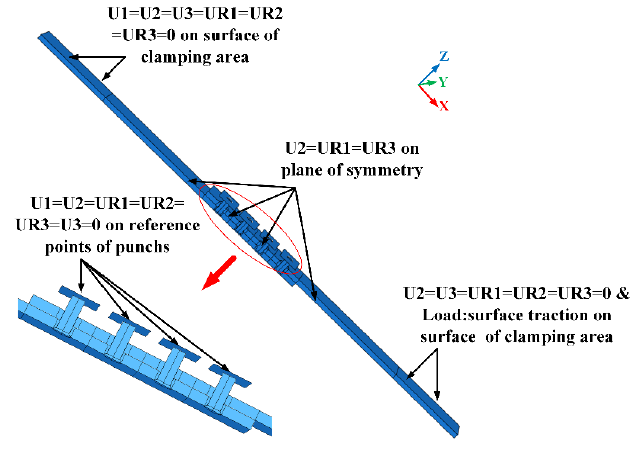
Figure 9. The boundary condition of the FE model in the tensile step.